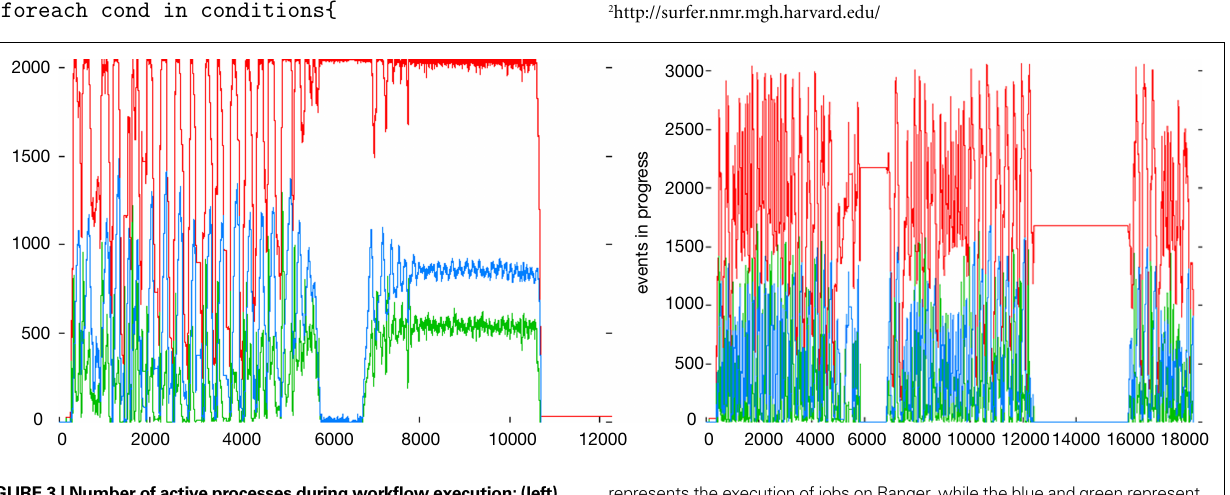
represents the execution of jobs on Ranger, while the blue and green represent the staging in and out of fi les respectively. Plots were generated by swift-plot-log, part of the Swift suite of